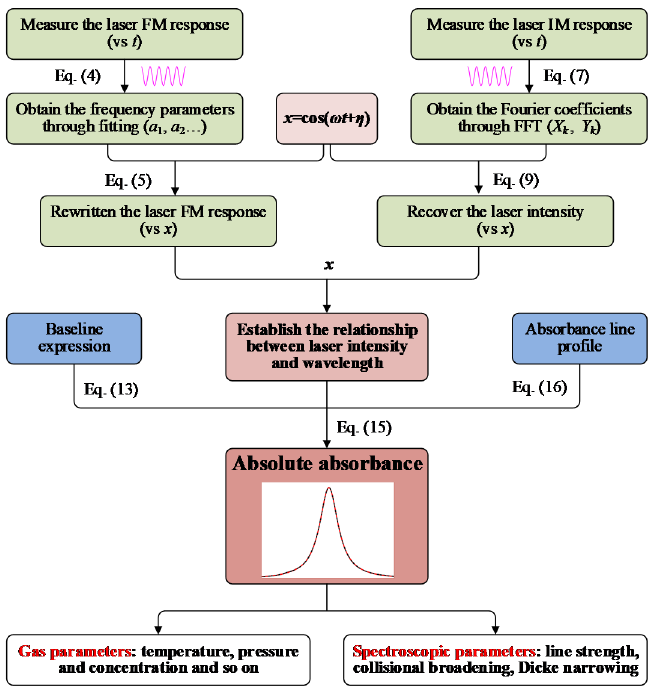
Figure 8. Flowchart for the proposed WM-DAS method.